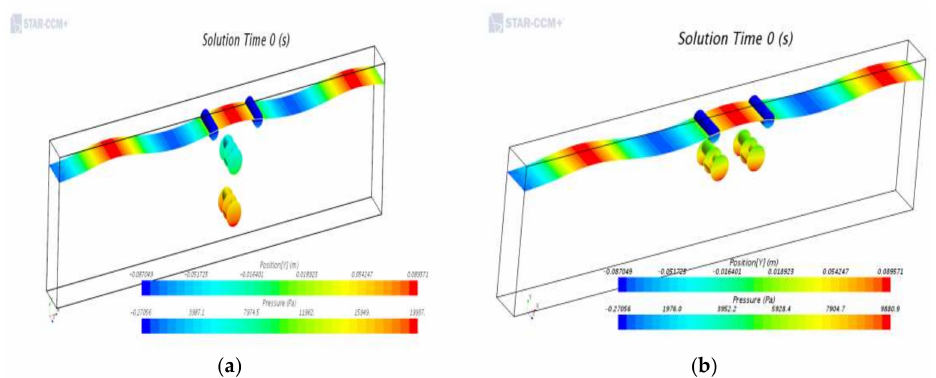
Figure 6. Hydrodynamic model of S-shaped blade ( a ) Hydrodynamic model of vertical blade arrangement; ( b ) Hydrodynamic model of parallel blade